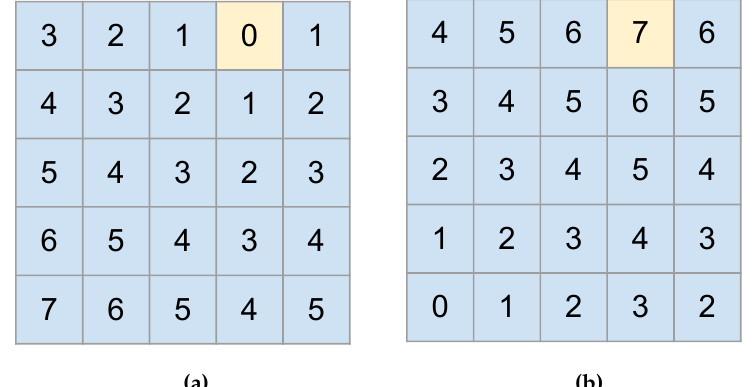
Figure 6. The matrices used on the generation of the Q-Table. In ( a ), we show the distance matrix with the end point painted in yellow color. In ( b ), we show the reward matrix that corresponds to the distance matrix minus the highest distance value, resulting in lower reward values to squares that are far from the end point, while the highest reward is on the end